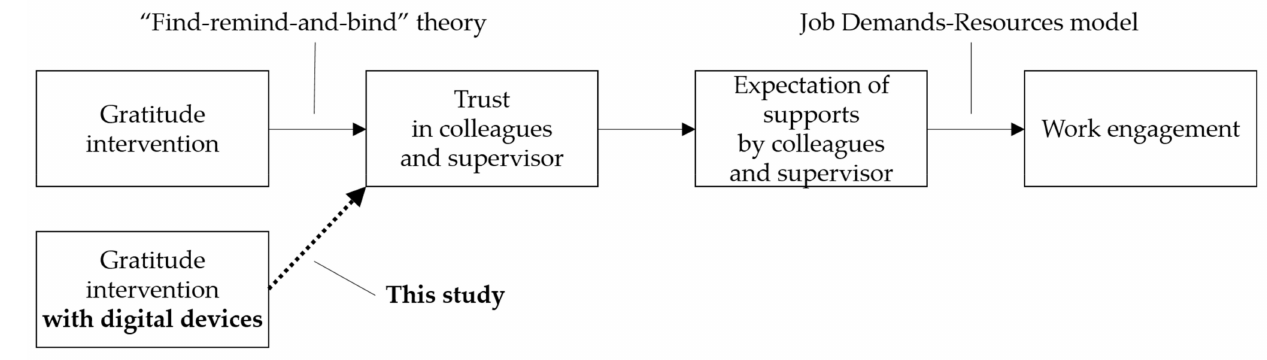
Figure 1. A conceptual model based on previous studies and the target of our